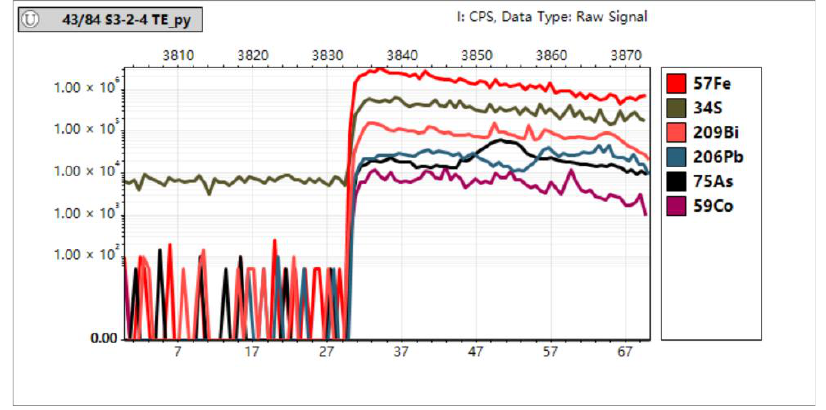
Figure 10. Time-resolved depth profiles of Bi, Pb, As, and Co in Sample S3-2.